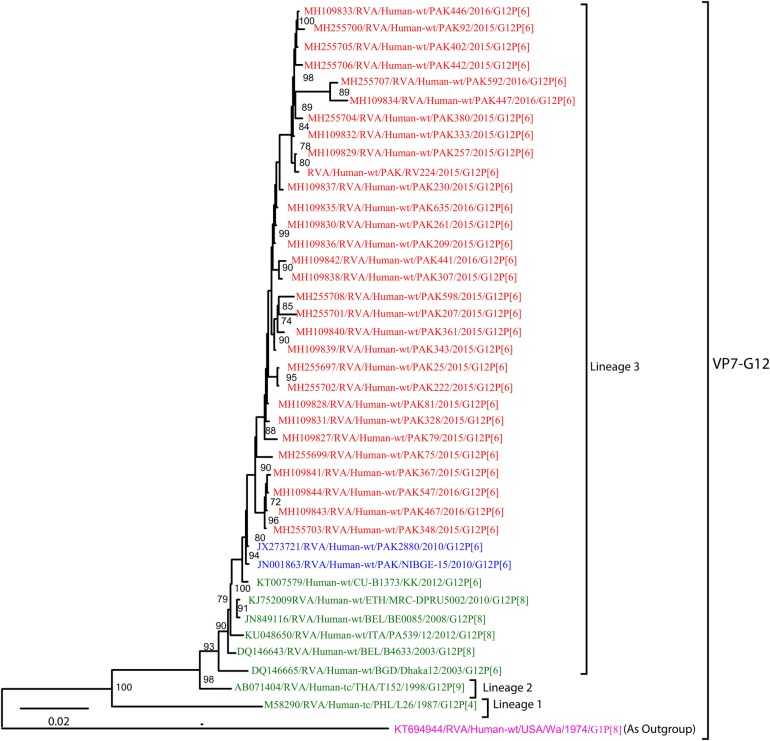
Maximum likelihood phylogenetic tree constructed from the nucleotide sequences of G12-VP7 strains and representative RVA strains with kimura-2-parameter model in MEGA program 6.0.Bootstrap values <60 are not shown. RVA strains sequenced in this study are represented by the red colour. Pakistani Strains reported in the previous studies are shown in blue. The out group strain is represented by purple colour while green shading represent strains isolated in all over the world. The RVA strains sequenced in this study and reference strains obtained from GenBank database are represented by Accession number, Strain Name, Country and year of Isolation. Scale bar: 0.02 substitutions per nucleotide.